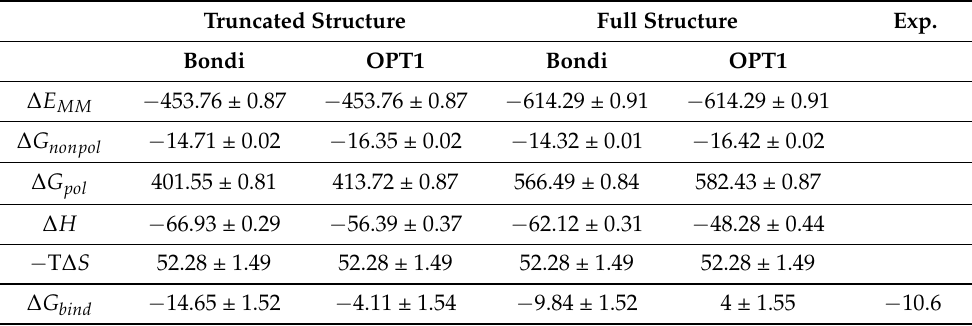
Table 2. MM/GBSA results on the truncated SARS-CoV-2 S RBD and ACE2 complex. Means and the standard errors of the mean are listed. All the components are in kcal/mol. Experimental value is derived from a fit to surface plasmon resonance sensogram